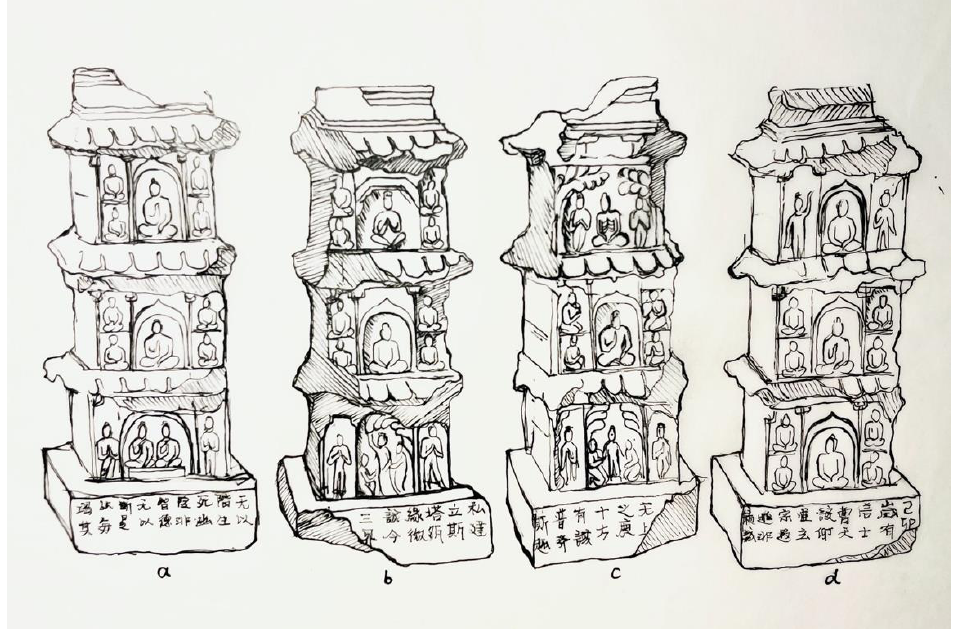
Figure 13. Cao Tianhu 曹天護 Pagoda. Jiuquan, Gansu Province. 499, Northern Wei. (Stone. H. 38 cm, W. (base) 16 cm. Jiuquan Municipal Museum. Diagram by the author based on photographs in Chen 1986, Figures